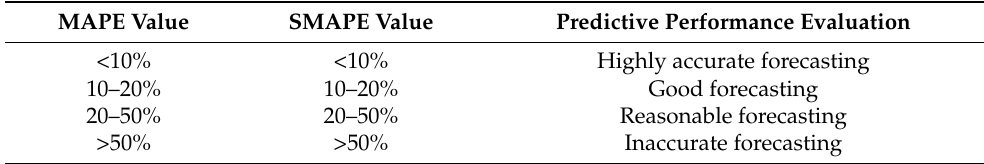
Table 1. Explanation of MAPE and SMAPE evaluation indicators. MAPE Value.